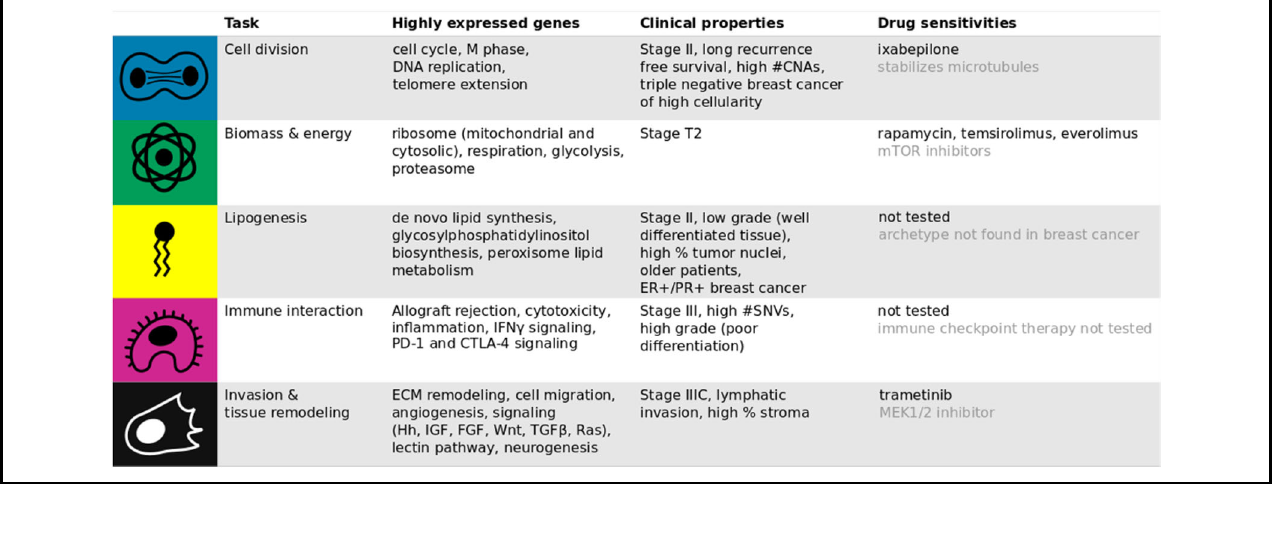
Table 2 Each cancer task is characterized by speci fi c gene expression programs and clinical properties.